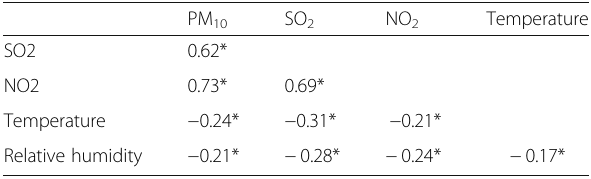
Table 2 Spearman correlation analysis between air